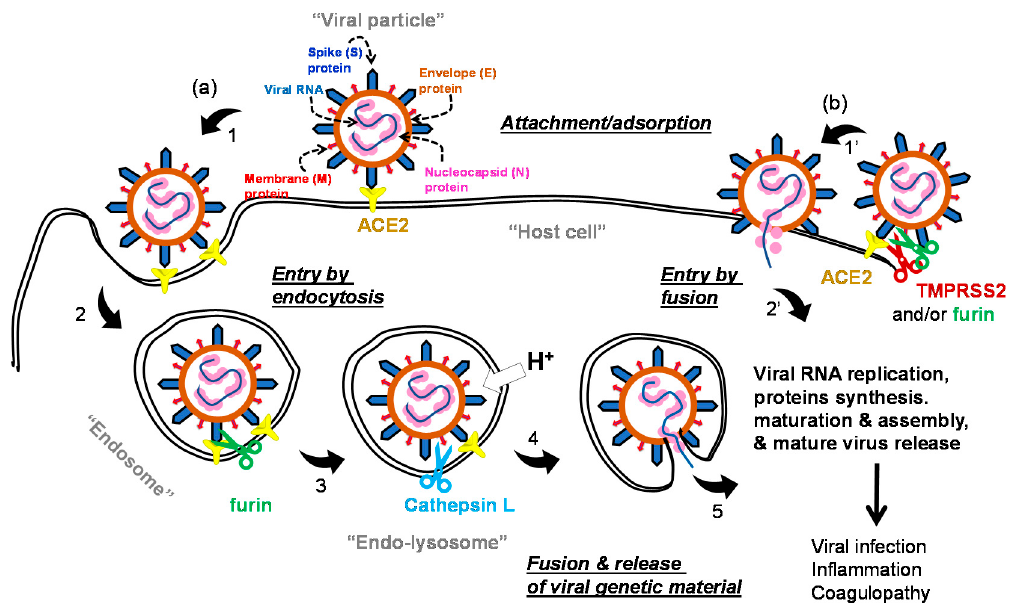
Figure 1. A representation of the viral particle of SARS-CoV-2 depicting the structural proteins: spike (S) protein, envelope (E) protein, membrane (M) protein, and nucleocapsid (N) protein. It also shows the early stage of the life cycle of the virus which starts by the spike S protein binding to the host cell ACE2, which is followed by viral entry. The viral entry takes place either by ( a ) endocytosis or ( b ) direct fusion. In endocytosis-mediated entry, the spike S protein activation appears to take place in endosomes by the action of furin. Further proteolysis and subsequent fusion occur because of the action of cathepsin L in endo-lysosomes. In direct fusion entry, the process is mediated by TMPRSS2 and/or furin; however, other trypsin-like proteases may also contribute. Either way, the RNA genetic material of the virus is released, and the late stage of the life cycle subsequently takes place by RNA replication, viral protein synthesis, maturation, assembly, and release of the new virus. The RNA genetic material of SARS-CoV-2 has ~29,811 nucleotides which encode for about 29 proteins: structural proteins (four proteins), nonstructural proteins (NSPs; 16 proteins), and accessory proteins (nine proteins) [43,44]. The virus has four structural proteins of the envelope (E),